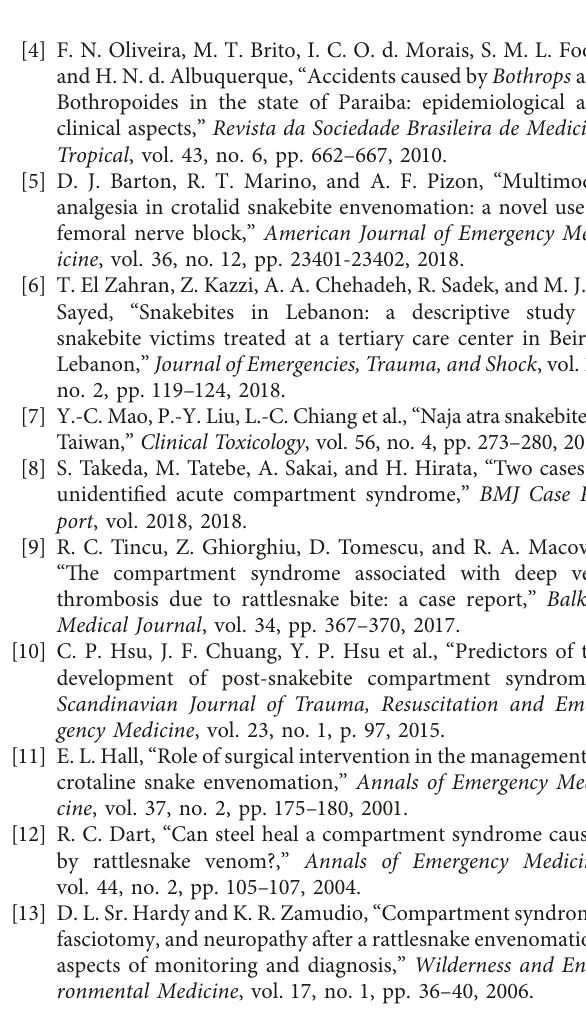
Figure 2: Compartment syndrome and required decompressive fasciotomies to reduce pressure within the affected